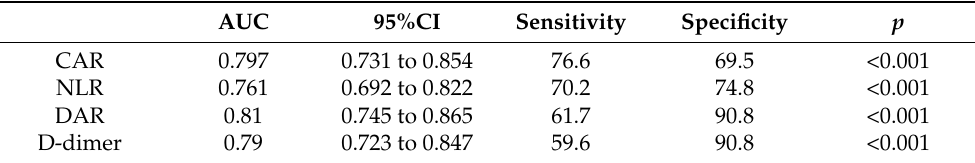
Figure 1. Correlation of the DAR with WFNS grade of aSAH patients on admission. Correlation of the DAR with World Federation of Neurological Surgeons Scale (WFNS) grade of aneurysmal subarachnoid hemorrhage (aSAH) patients on admission (r = 0.397, p < 0.001). Table 2. Receiver Operating Characteristic Curves for Predicting 3-month Post subarachnoid Hemorrhage Outcome.